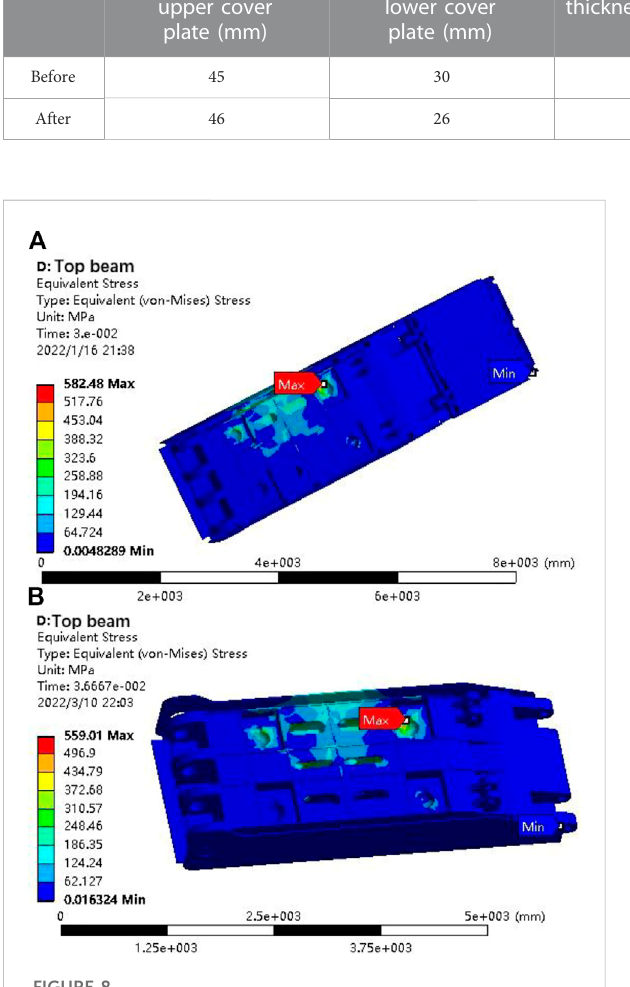
FIGURE 8 Stressclouddiagramofthetopbeam (A) beforeoptimizationand (B) after